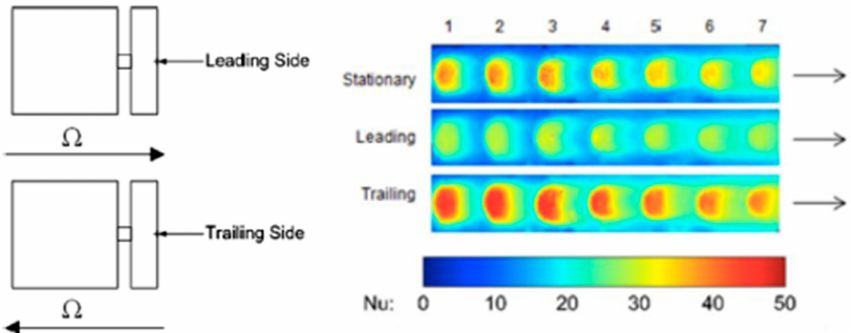
Figure 15. Leading edge jet impingement and detailed Nusselt number map under rotating condi- tions